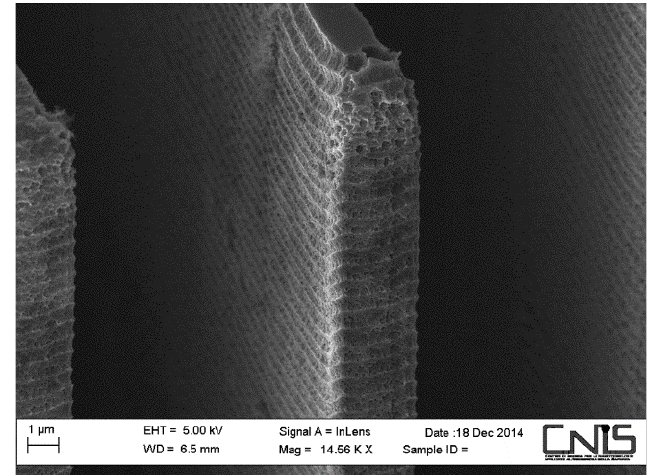
Figure 11. Scalloping effect on comb drive fingers.